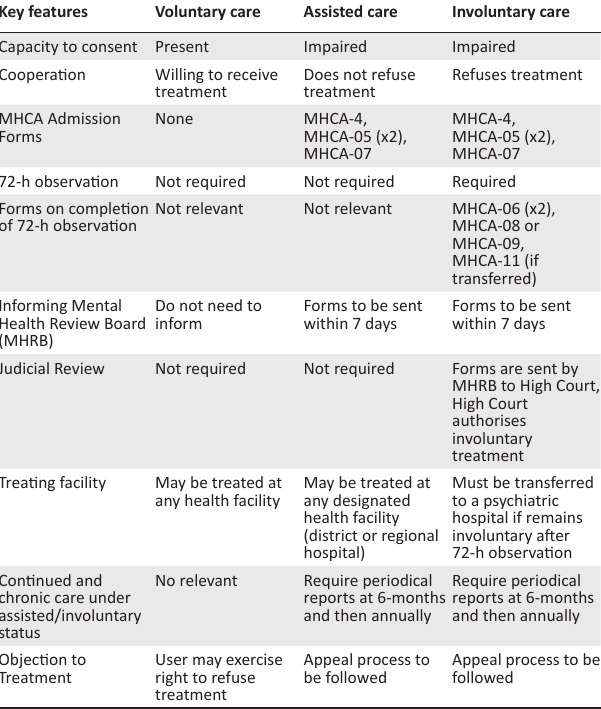
TABLE 1: Similarities and differences between voluntary, assisted, and involuntary care as described by the Mental Health Care Act 17 of 2002 (MHCA). Key features